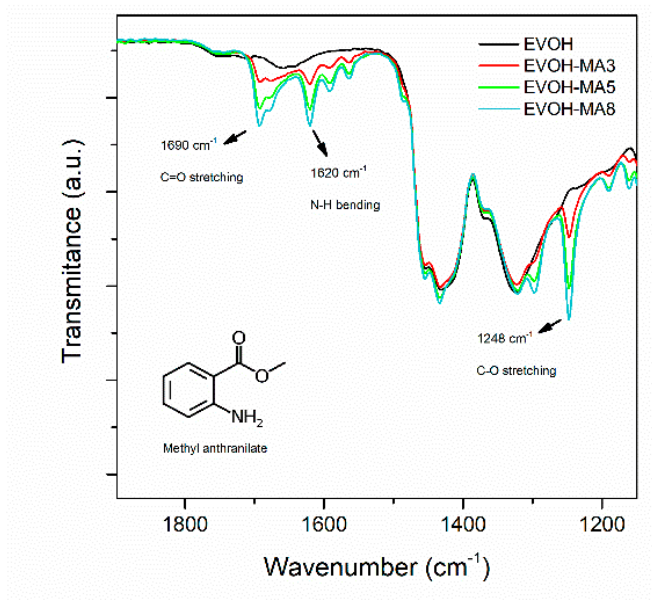
Figure 2. FT-IR spectra of EVOH-MA samples.